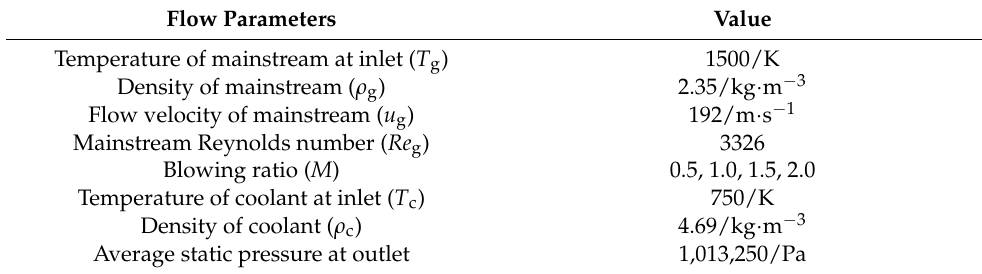
Table 1. Parameters for boundary